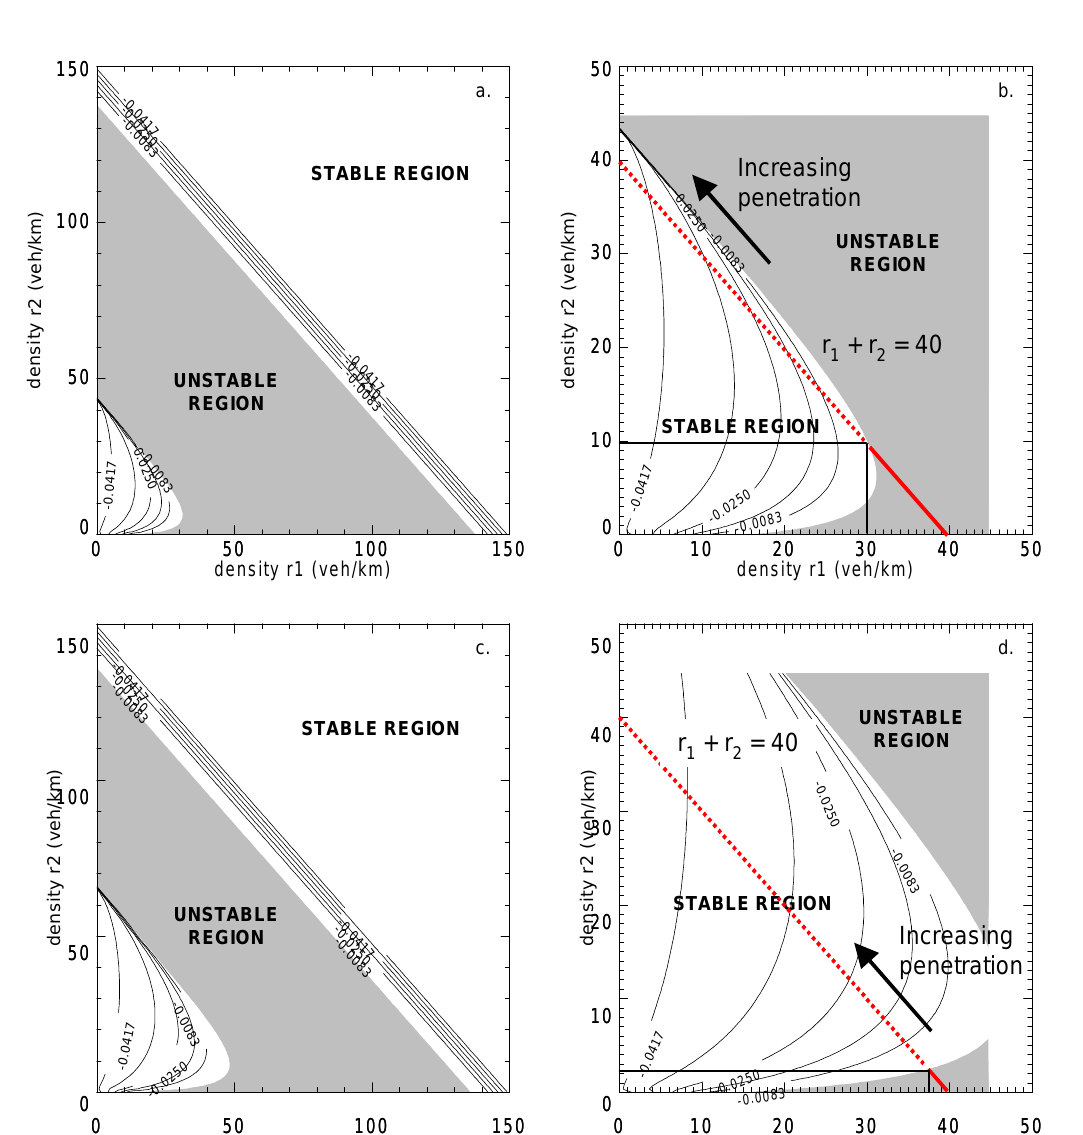
Figure 3. Stable and unstable density regions for ISA speed limits respectively equal to 720 km/h (a,b), and 50 km/h (c,d) (Hoogendoorn,